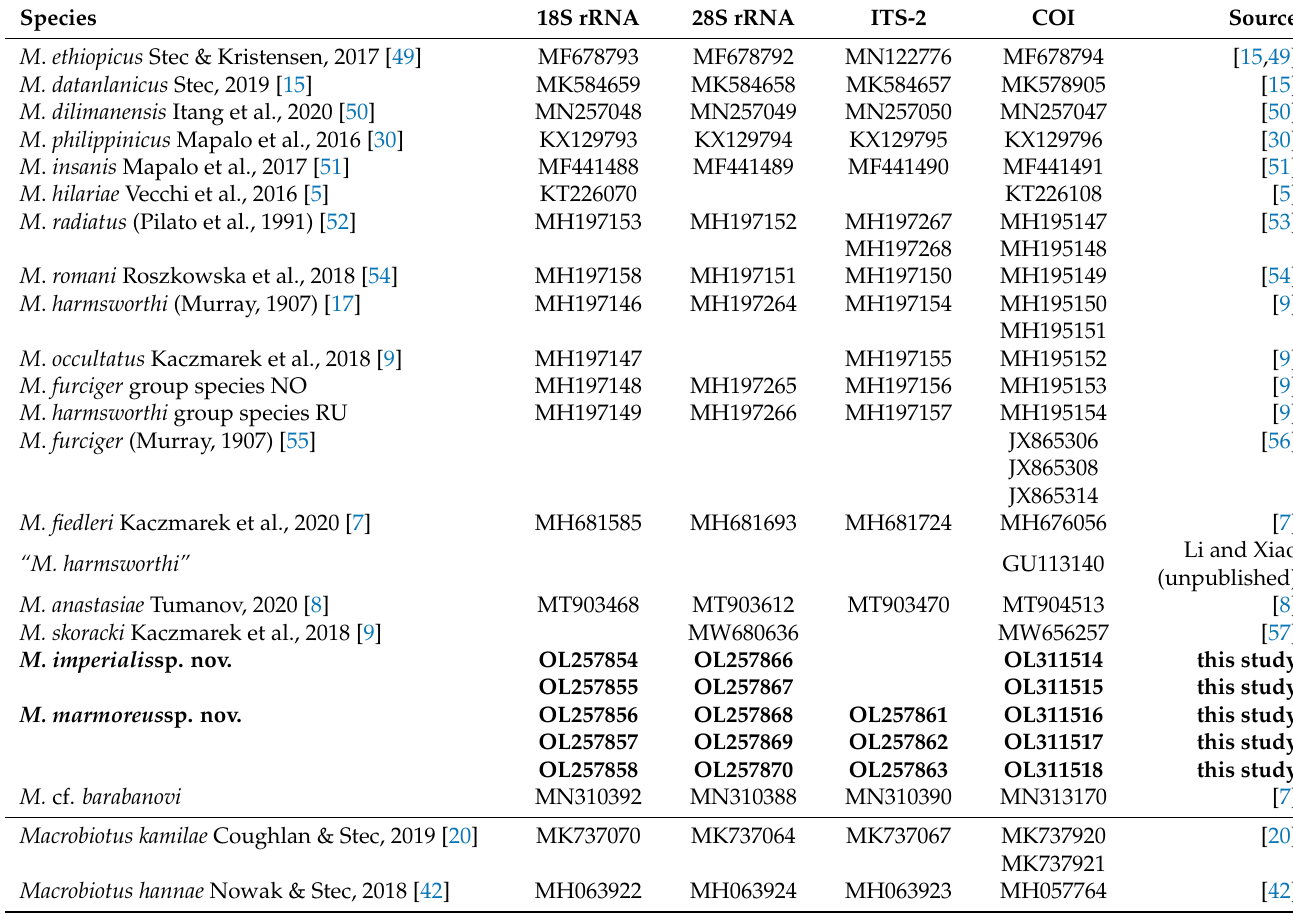
Table 2. Sequences used for phylogenetic analysis and genetic comparisons (see Material and Methods section for details). Bold font indicates sequences obtained in this